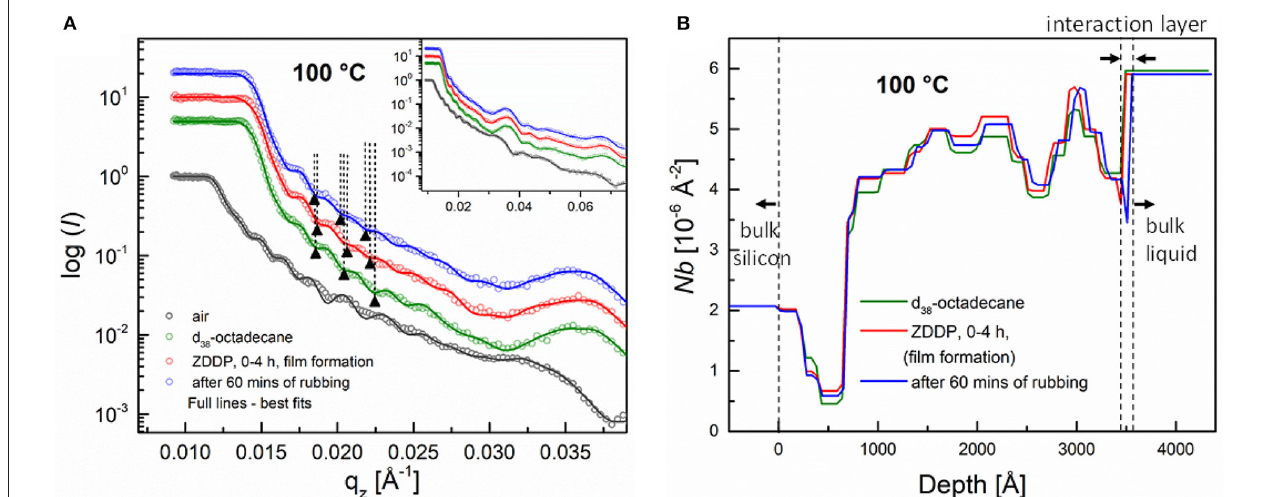
FIGURE 10 | (A) Neutron reflectivity profiles (dots) and best fits (continuous lines) for an a-C:H coating measured at 100 ◦ C in air, in deuterated octadecane, in presence of a 1 wt.% ZDDP solution and finally after rubbing in the presence of ZDDP. Inset shows profiles over the whole q z range. (B) The SLD profiles extracted from fitted curves. The SLD profile for an a-C:H coating in air is omitted for the sake of